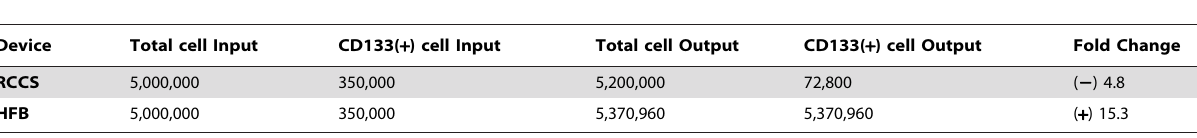
Table 2. Comparison of CD133( + ) and ( 2 ) cel counts 6 standard deviation of SAOS-2 cells grown in the HFB or RCCS vessels.